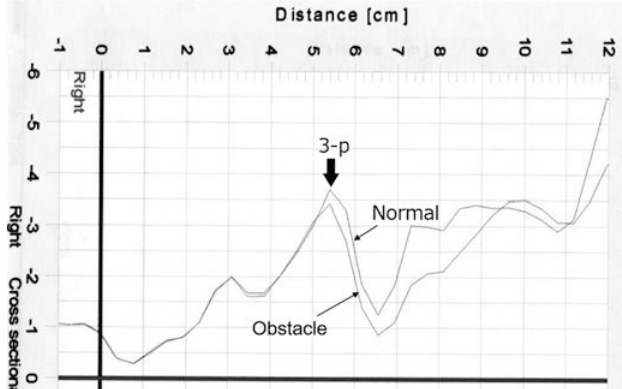
Figure 4 Changes in the area–distance curve with inferior turbinate hypertrophy. Changes in the nasal inferior turbinate began at the second notch and diminished immediately before the third peak on the area– distance curve.